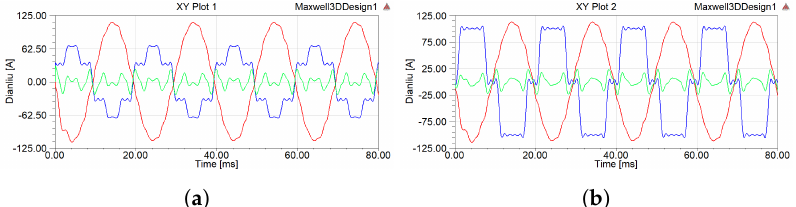
Figure 8. Current waveforms of grid-side and valve-side windings under working condition 3. ( a ) The left column. ( b ) The right column.